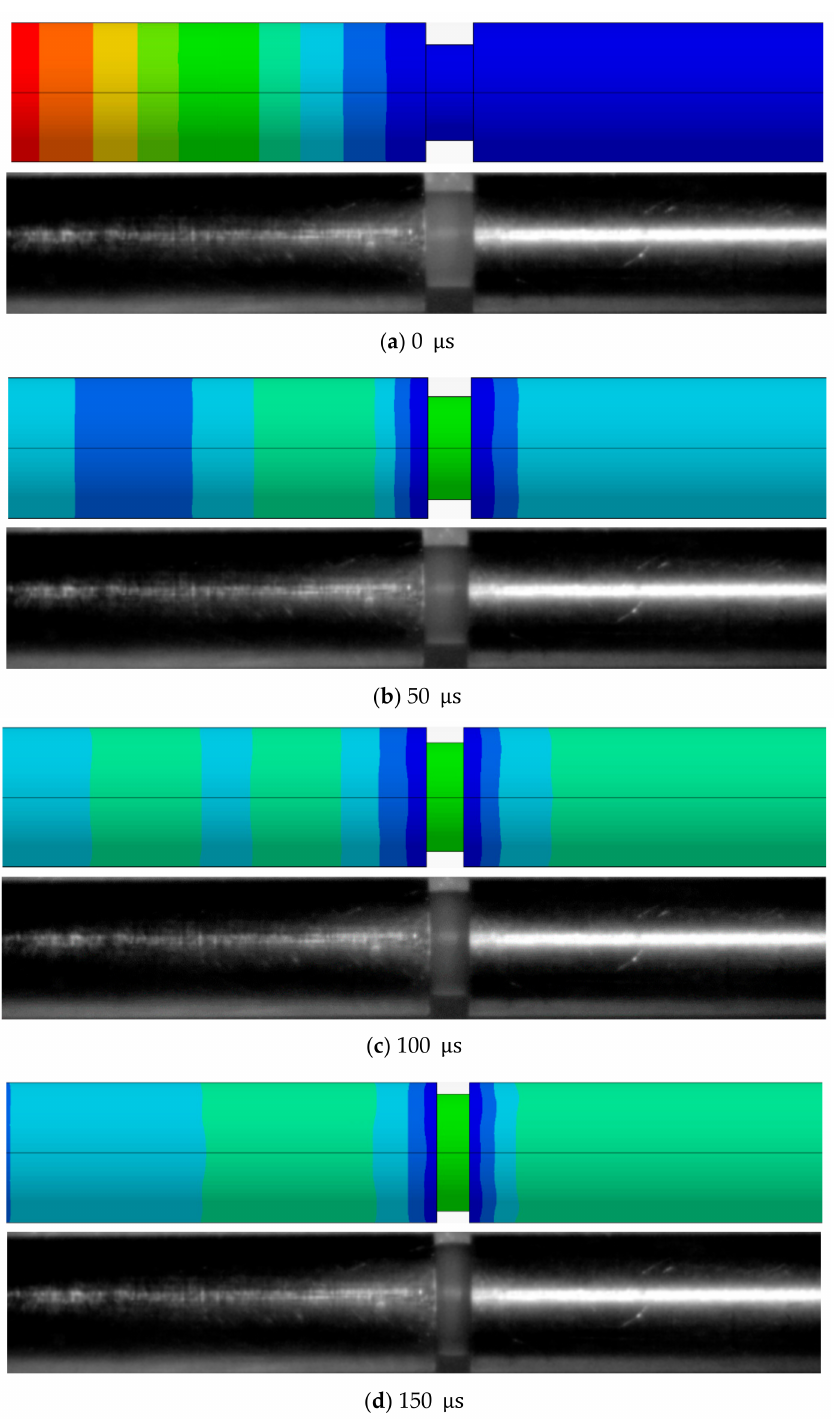
Figure 13. Comparison between specimen deformations in test and simulation at different